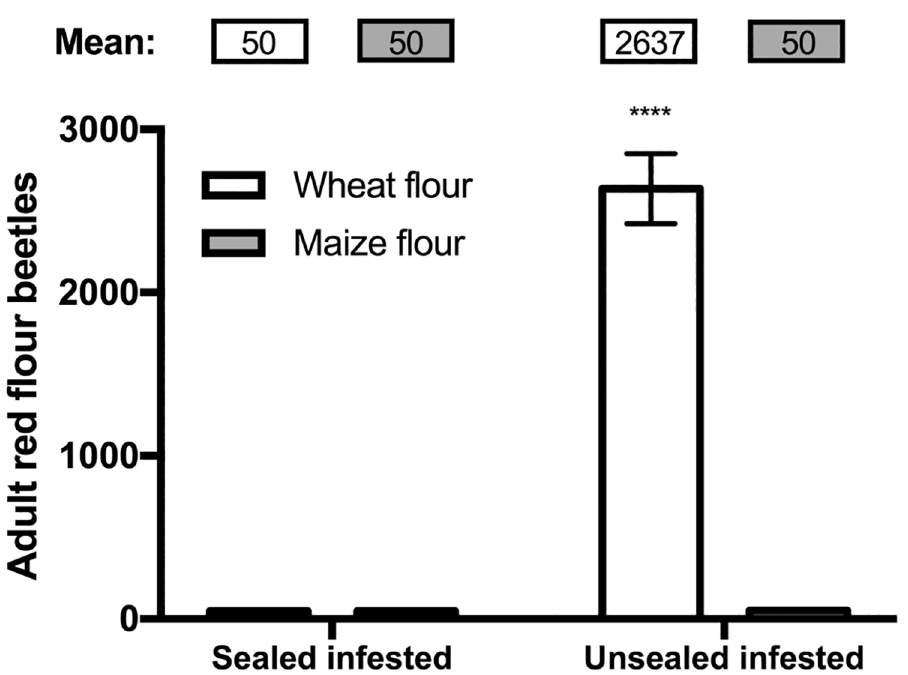
Fig 2. Adult red flour beetle (RFB) population sizes after three months under different storage conditions. The adult populations found in wheat flour in the unsealed infested bottles increasedsome 5-fold after three months, while the adult populationsin other infested groups remained the same as was present initially(Sealedcondition: F (1, 8) = 144, P < 0.001; Flour type: F (1, 8) = 143.7, P < 0.0001). Columnheights show the mean and the error bars represent the standard error of the mean. “ **** ”represents P <